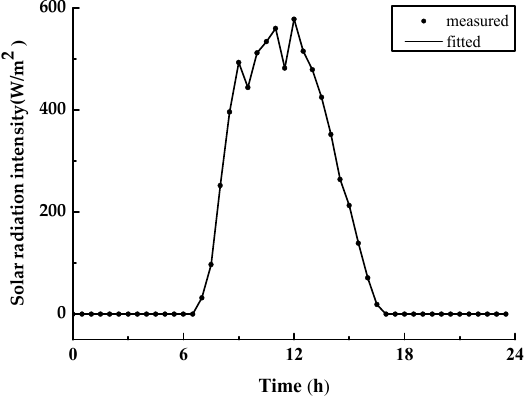
Figure 4. Measured and fitted solar radiation intensity on 16 December.